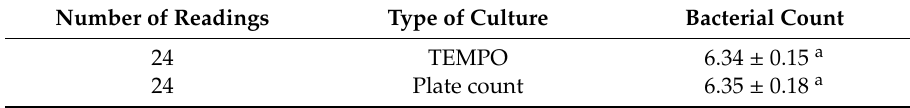
Table 2. Comparison of cell counts (log CFU / cm 2 ) between TEMPO and conventional plate